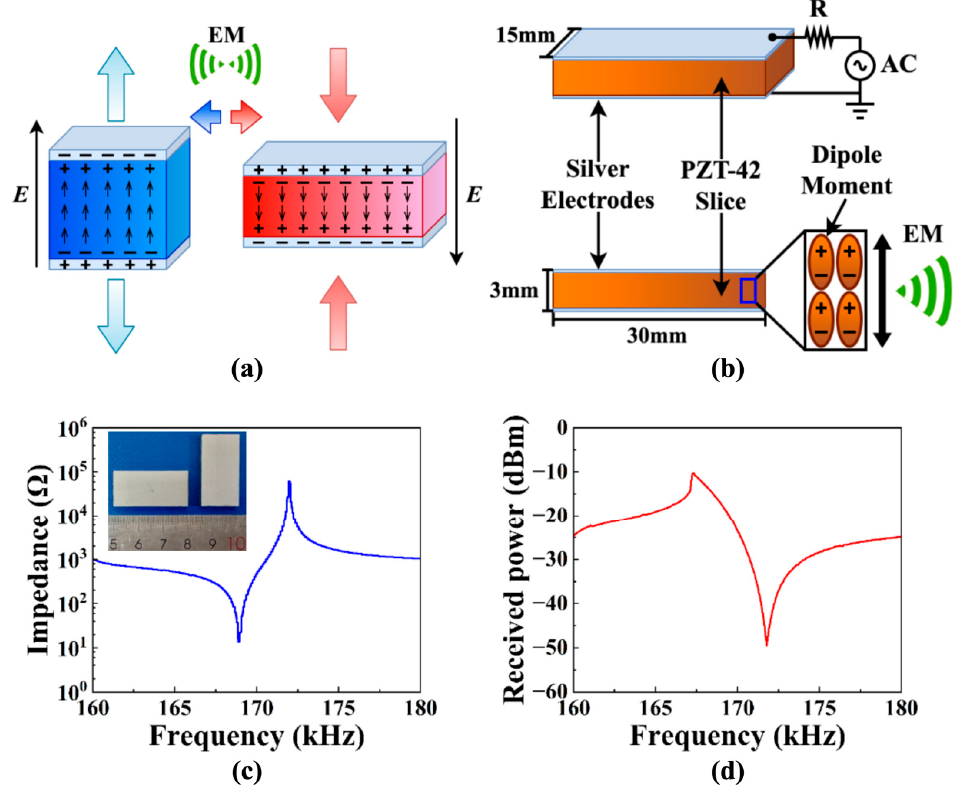
Figure 1. Mechanism and performance of the PZT-42 mechanical antenna. ( a ) Simplified illustration of the working mechanism. ( b ) The PZT-42 resonator in 3D and from the side. ( c ) Impedance curve of the PZT-42 mechanical antenna in the range of 160–180 kHz. ( d ) Received wireless spectrum using the PZT-42 mechanical antenna in the range of 160–180 kHz.